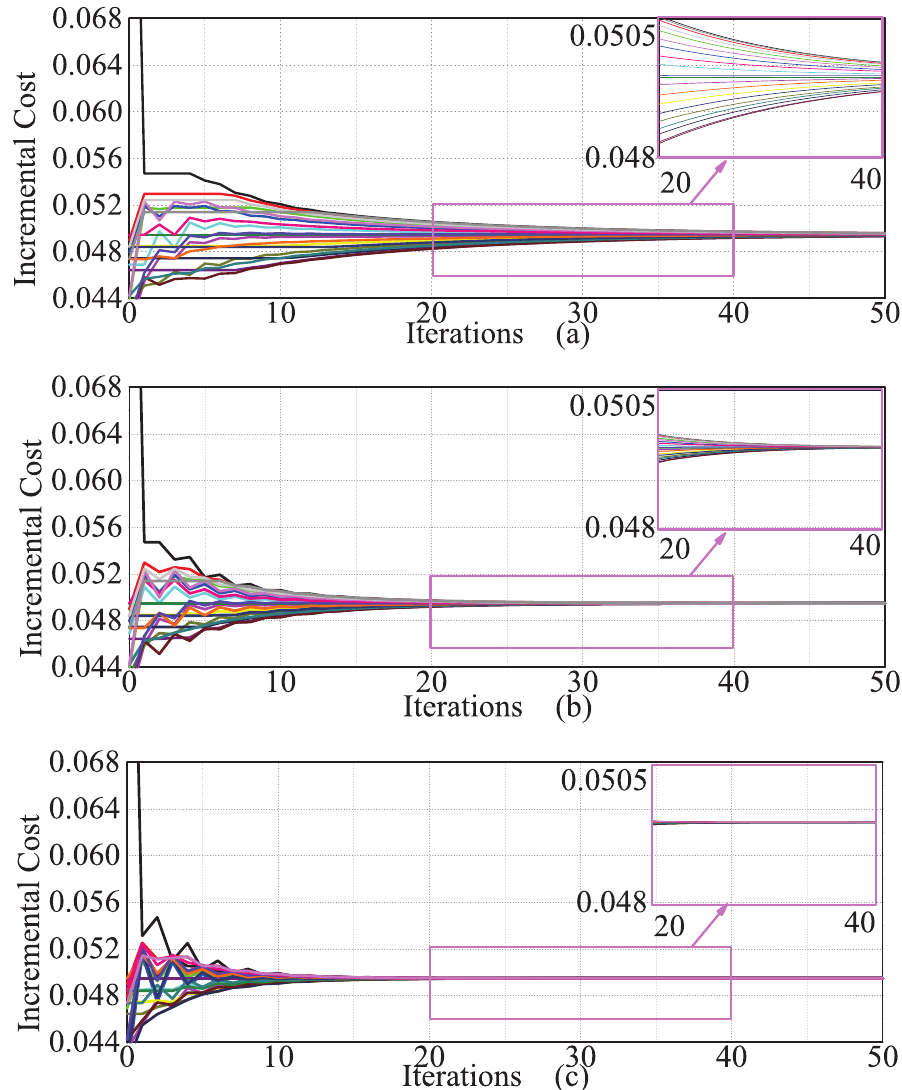
Figure 9. Convergence test of the EPD algorithm for a DC microgrid with 20 DGs when the communication network among agents is designed with different topologies. ( a ) Each agent communicates with its six adjacent neighbors; ( b ) each agent communicates with its eight adjacent neighbors; ( c ) each agent communicates with its ten adjacent